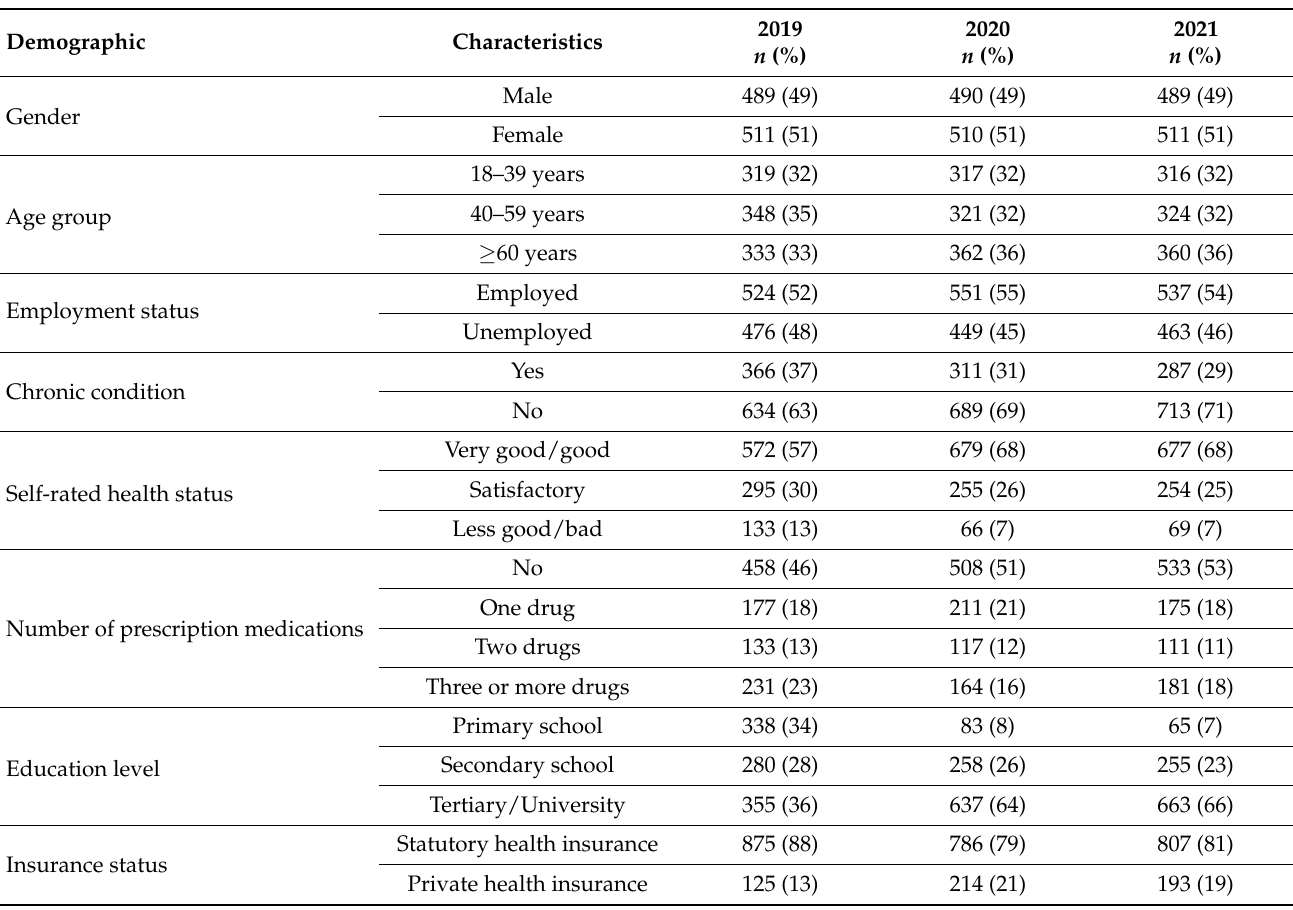
Table 1. Socio-demographic characteristics from 2019 to